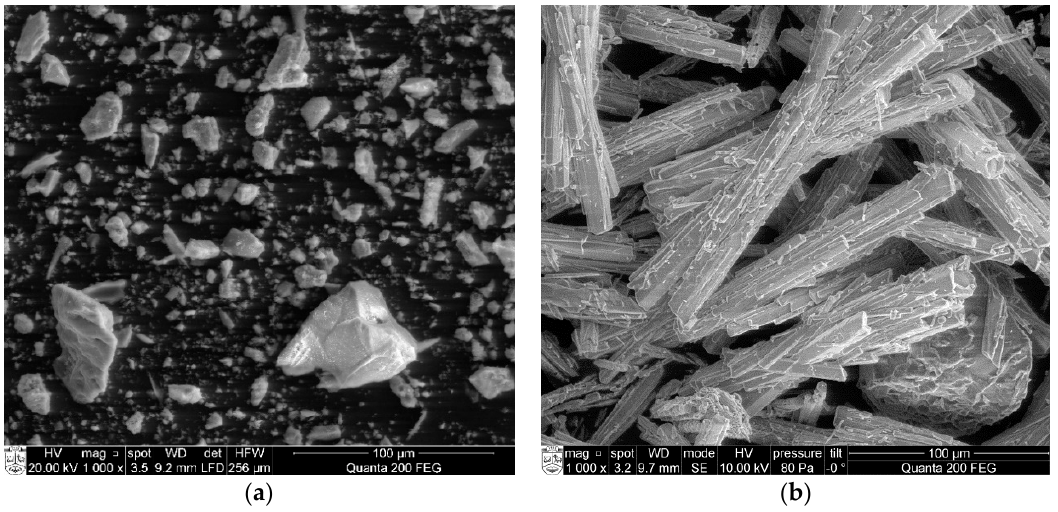
Figure 1. Microstructure of ( a ) biomass bottom ash and ( b ) phosphogypsum.